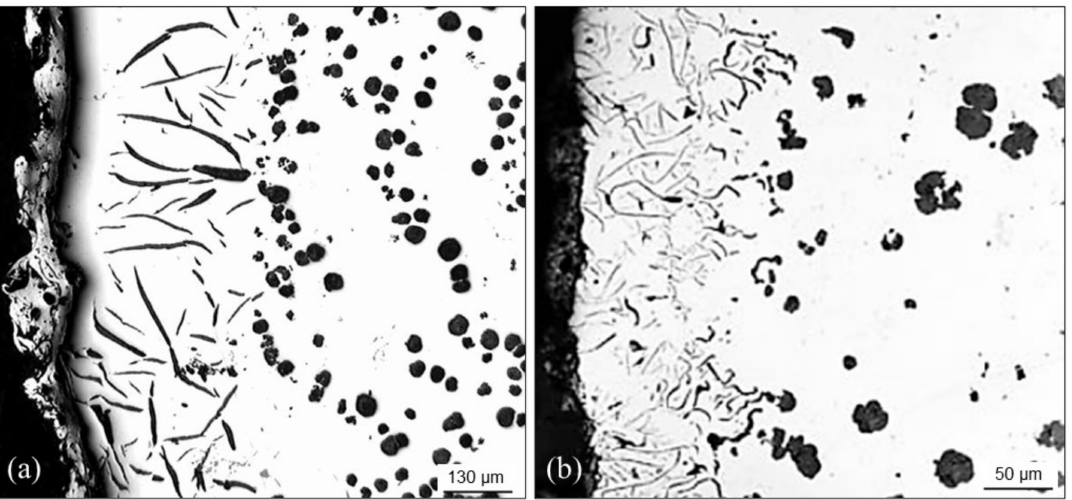
Figure 59. Graphite degeneration in the outer areas of ( a ) a heavy-section ductile iron casting in contact with a core produced using sand mixtures bonded with furanic resins and sulfonic acid; ( b ) a ductile iron casting (the latter is reprinted with permission from ref. [45]. Copyright 1994